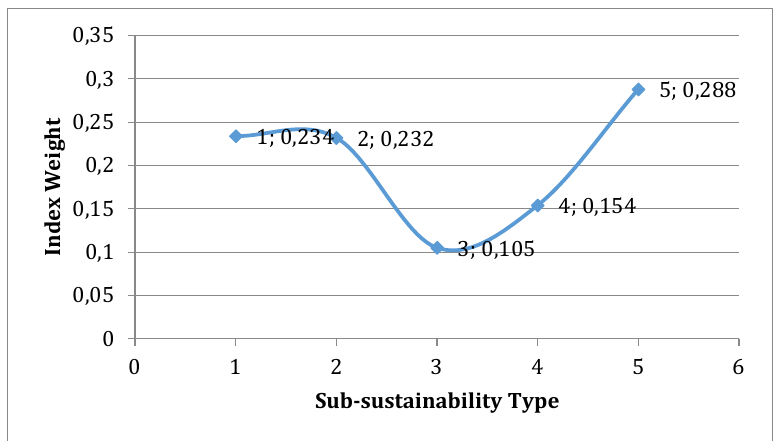
Figure 32: Sub-sustainability assessment index weight